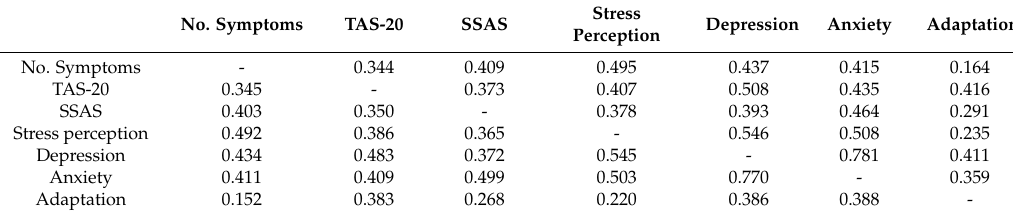
Table 2. Correlations of the total number of somatic symptoms (No. Symptoms) with scores on the 20-item Toronto Alexithymia Scale (TAS-20), Somatosensory Amplification Scale (SSAS), Stress Perception Scale (Stress Perception), the Profile of Mood States depression scale) (Depression), tension–anxiety scale (the Profile of Mood States anxiety scale) (Anxiety), and the Adapted Child scale of the Tokyo University Egogram